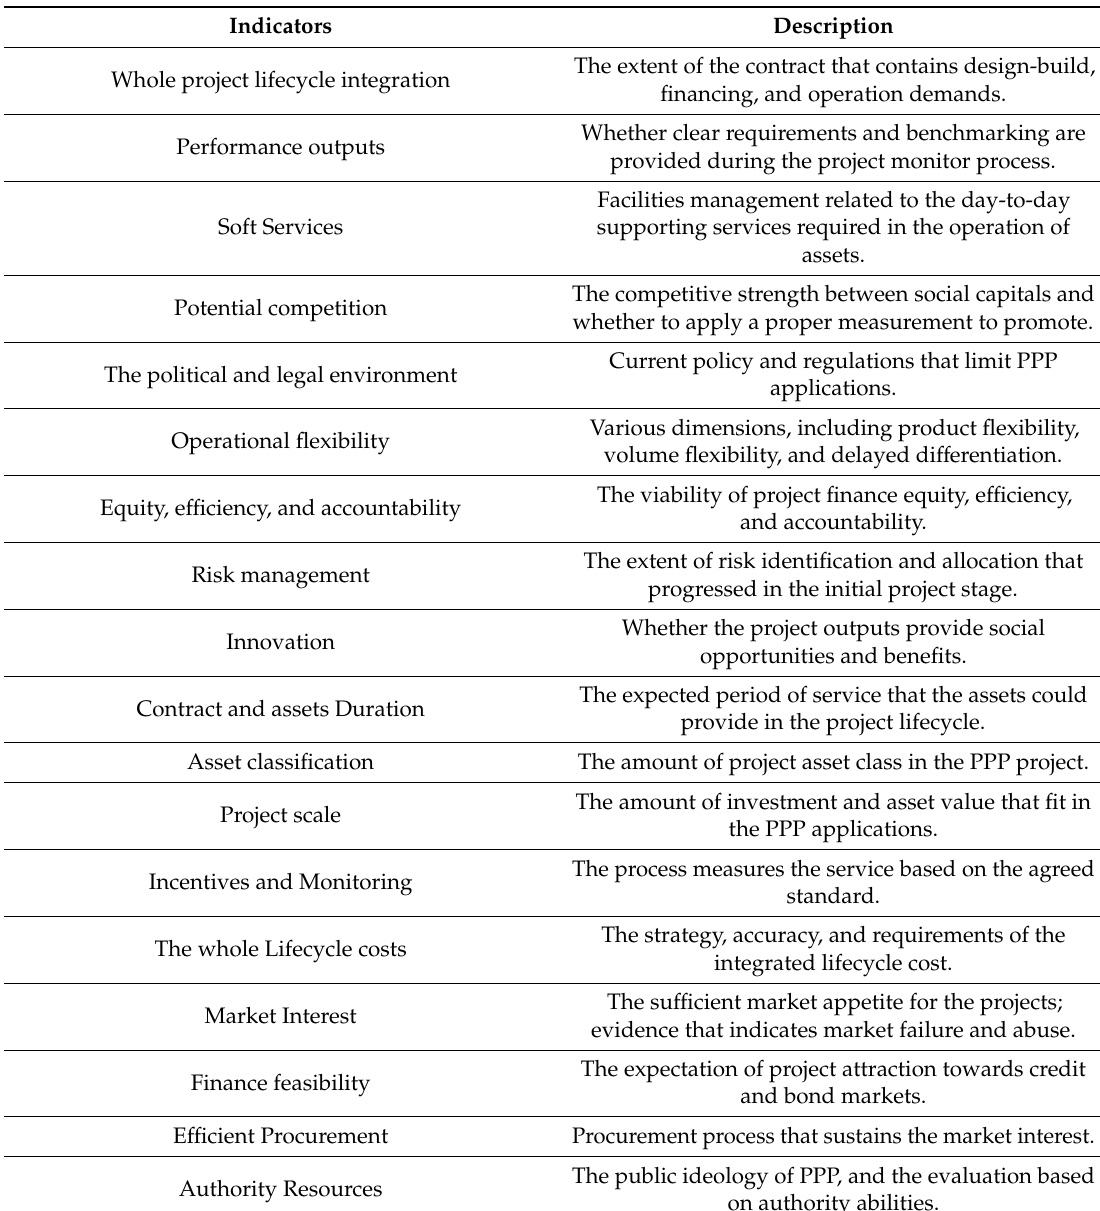
Table 4. VfM qualitative assessment indicators in China and the UK. Source: values for money assessment guidance